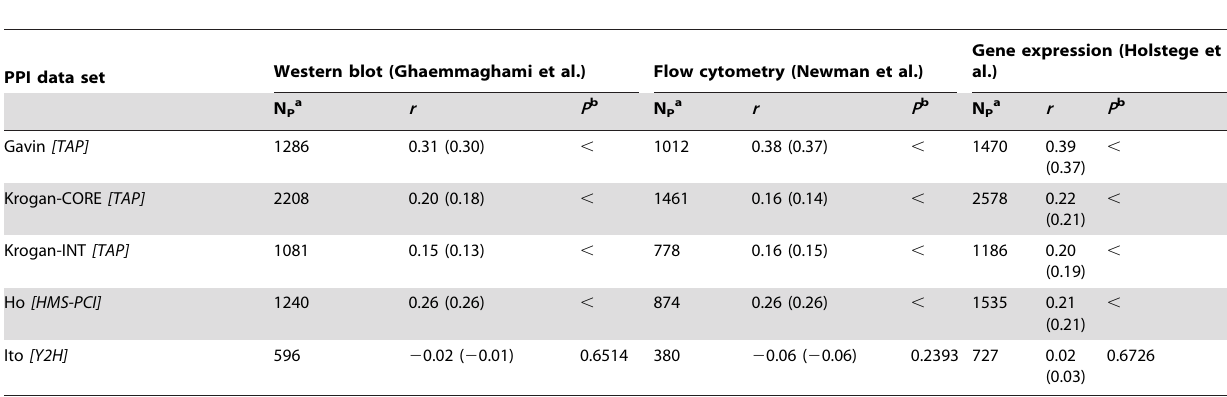
Table 3. Pearson correlation coefficients ( r ) and corresponding P -values for tests of linear association between log(degree) and log 2 (abundance) in high-confidence yeast PPI data